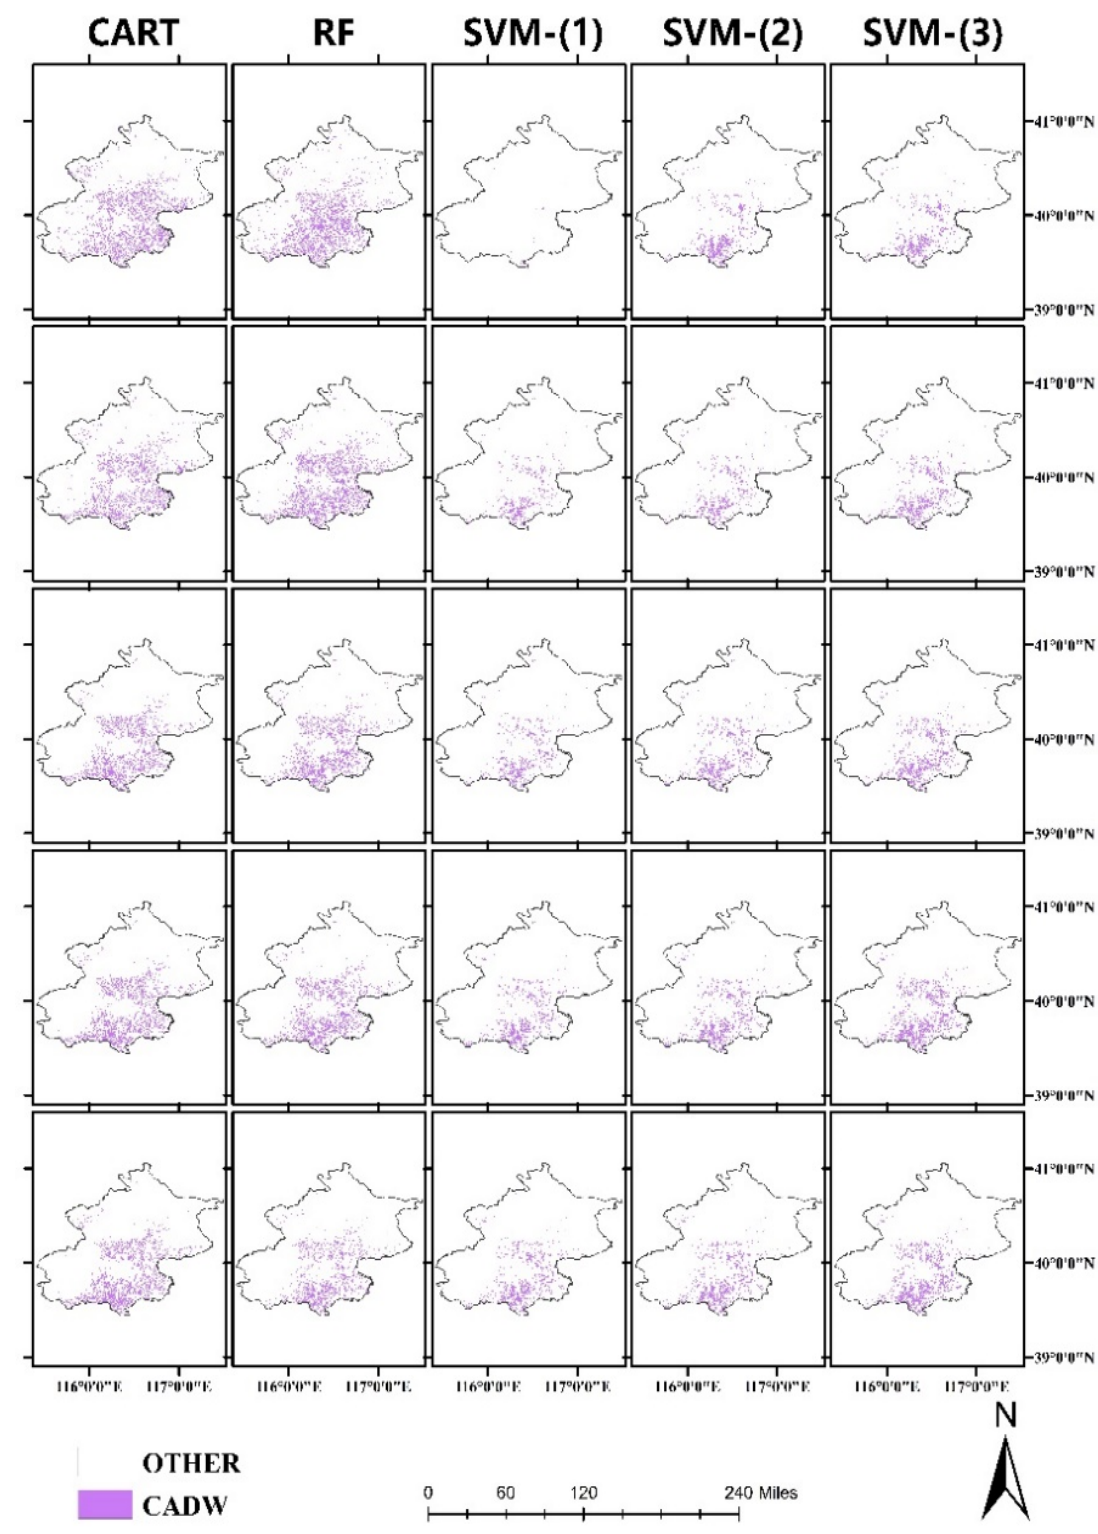
Figure 7. Distribution of C&DW by CART, RF, and SVM algorithms in Beijing. SVM-(1) cost=10; SVM-(2) gamma=5; SVM- (3) gamma=16.